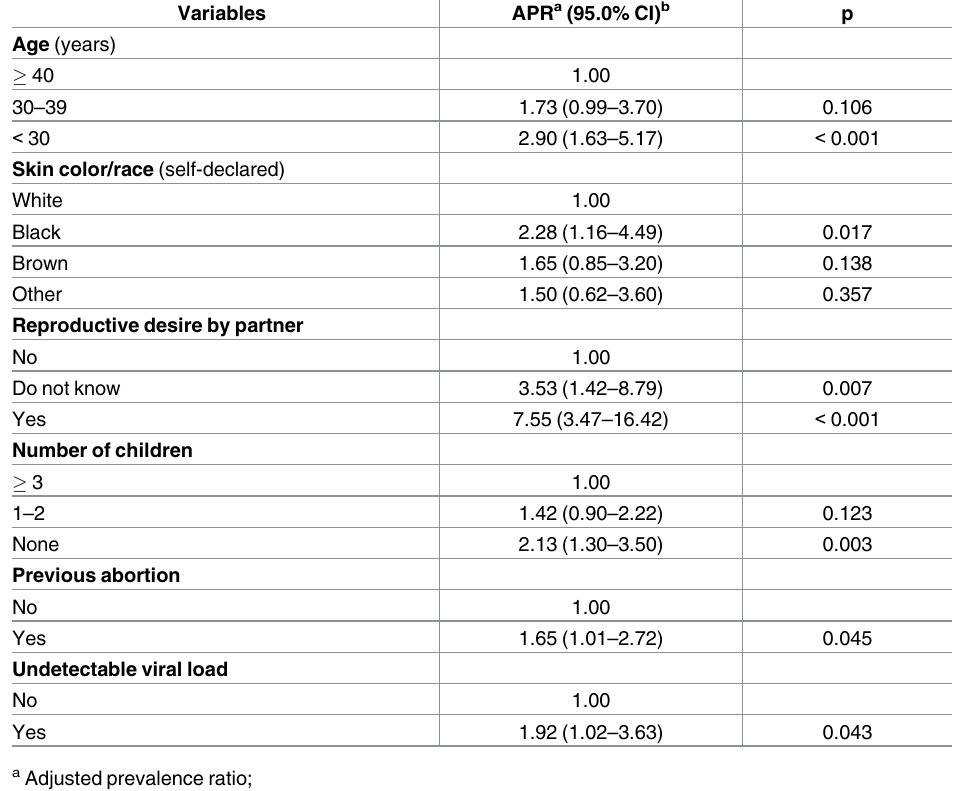
Table 5. Factors associatedwith reproductive desire in WLWHA in Central Brazil,